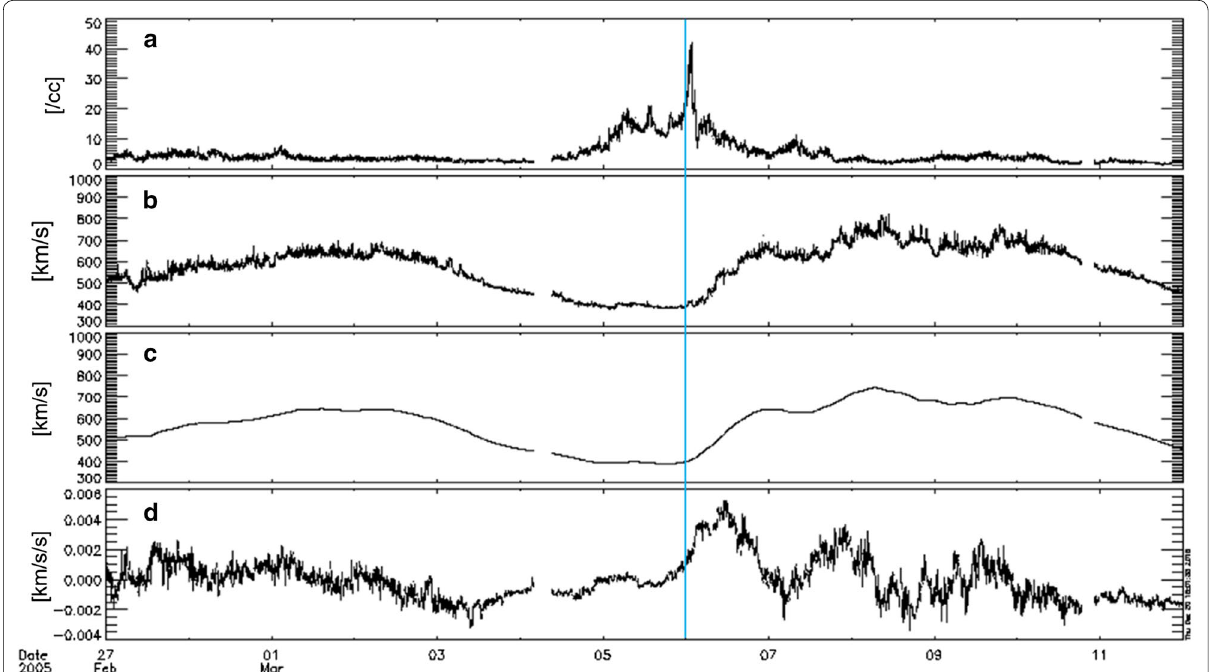
Fig. 1 The variations of the solar wind proton density and flow speed provided by CDAweb from February 27 to March 12, 2005. The time resolution is 1 min. a The variation of the solar wind density, b the variation of the solar wind flow speed. c , d Represents the half day moving average and the first derivative of the speed. The vertical light blue line represents the day of the maximum value of the solar wind density and the enhancement of the solar wind velocity around the Earth’s